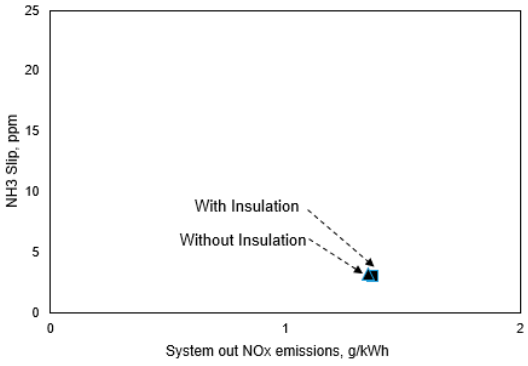
Figure 7. NOx emission and NH 3 lip results with insulation and without insulation during NRTC.